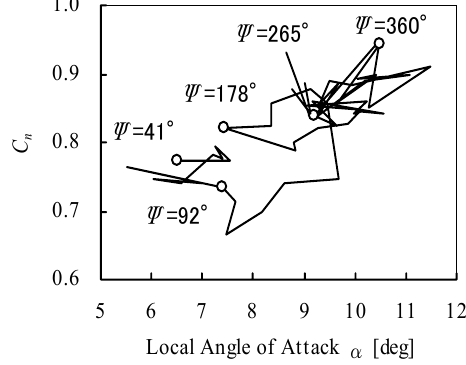
Airfoil Performance by Wind Shear Figure 9 shows the airfoil Fig.10 Instantaneous normal force coefficient performance against the local angle of C against instantaneous local angle of attack n attack α , which was reduced in standard α at σ = 0.5 m/s U ⊥ deviation σ of wind velocity normal U ⊥ to the rotor plane. Figure 9(a) shows 0.50.60.70.80.91.0 the direction of the normal force coefficient C to the local angle of n attack α . The tendency that the value of C decreases with increasing σ n U ⊥ can be seen in the whole area of α . Figure 9(b) shows the tangential force coefficient C to the local angle of t attack α . The tendency that the value of C decreases with increasing σ t U ⊥ Standard Deviation of Wind Speed can be seen in the whole area of α . [m/s] Perpendicular to Rotor Plane σ U ⊥ Figure 9(c) shows the moment coefficient C to the local angle of Fig.11 Normal force coefficient C against m n attack α . The tendency that the value standard deviation of wind speed of C increases with increasing σ perpendicular to rotor plane σ m U ⊥ U ⊥ can be seen in the whole area of α . These results are spatial averaged values, however, the profile of the wind velocity is non-uniform and unsteady, meaning that W , α , and β change periodically during one rotor revolution. Figure 10 shows the instantaneous value of the normal force coefficient C n against the instantaneous value of the local angle of attack α . This figure Standard Deviation of Wind Speed shows the results calculated from the [m/s] Perpendicular to Rotor Plane σ data during one rotor revolution at α =9° U ⊥ and σ =0.5 m/s given in Fig.9. Fig.12 Standard deviation of normal force U ⊥ Because of the effect of hysteresis, a against standard deviation of coefficient σ Cn difference in the value of C appears wind speed perpendicular to rotor plane σ n U